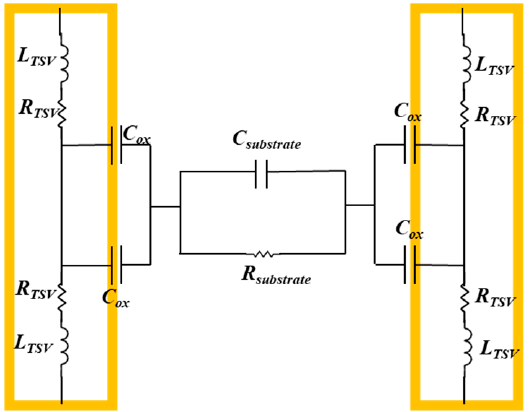
Figure 1. Coupling circuit between TSV.